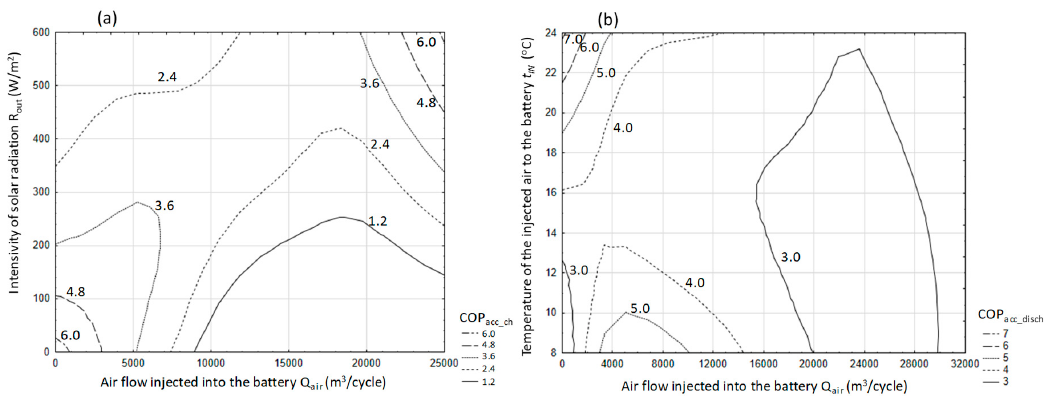
Figure 15. The course of the energy efficiency coefficient of performance (COP) for the process of charging ( a ) and discharging ( b ) a stone-bed accumulator.